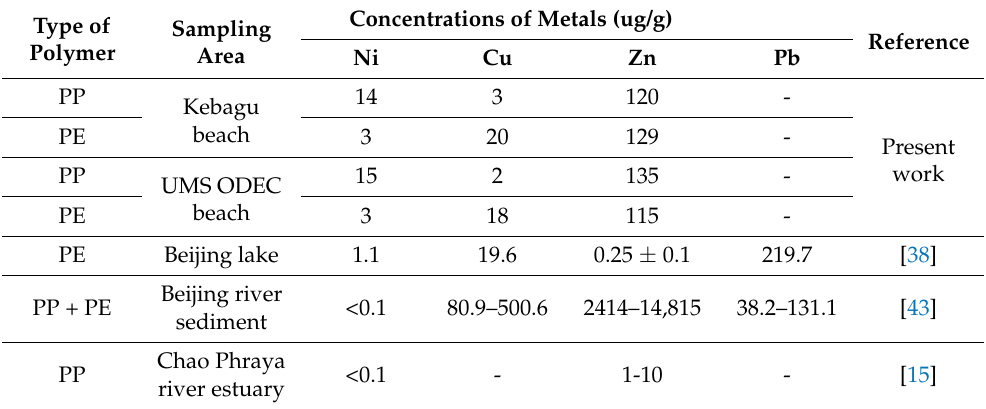
Table 2. Concentration of metals accumulated by microplastics, from previous